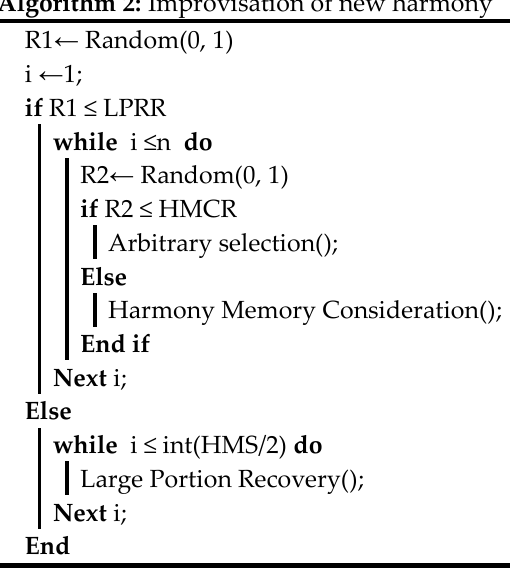
Figure 5. Improvisation of the New Harmony algorithm.